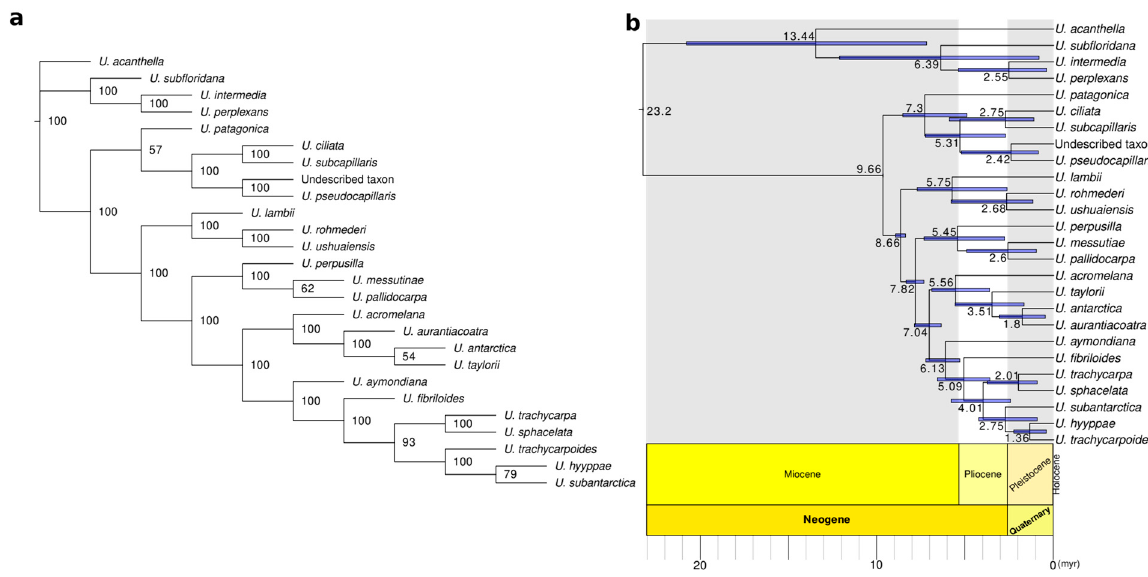
Figure 2. ( a ) SVDquartets species tree of neuropogonoid lichens for m4 dataset. BS are indicated for each node.; ( b ) Time-calibrated phylogeny obtained from treePL by using maximum clade credibility from bootstrap trees of the maximum-likelihood analysis of the m4 of reduced sampling matrix. Bootstrap supports (BS) for all branches are 100 except for the subclade U. pallidocarpa – U. messutiae with BS = 92. Mean ages in millions of years (myr) are indicated for each node. Node bars in blue indicate the node age ranges taking into account the branch length variance along the bootstrap trees. The international stratigraphic scale is included from 23 myr until the present.